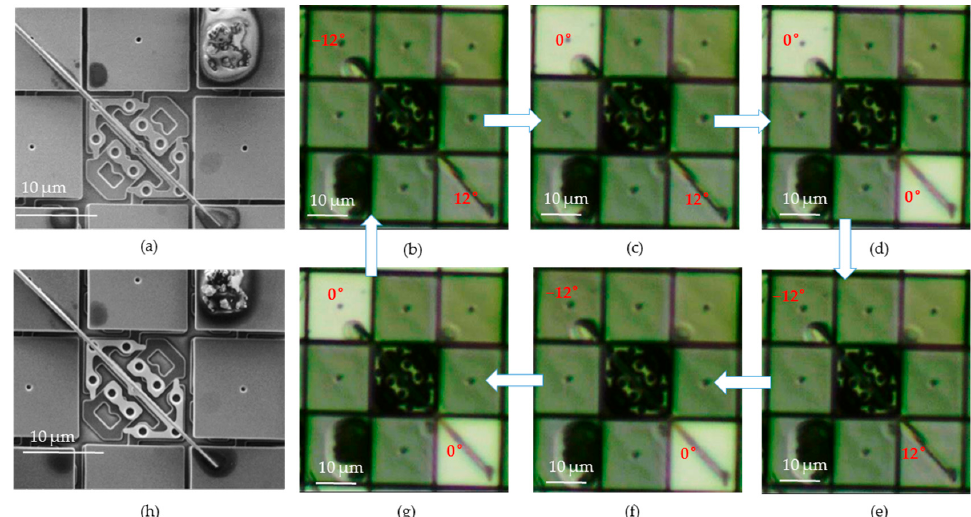
Figure 5. Cyclic torsional loading on a nanowire with maximum 24° twisting: From ( b ) to ( g ), the rotation angle changes as the picture shows. The maximum total torsion angle is 24° in this case (12° + 12°), with two diagonal mirrors titled in opposite directions. ( a ) shows the original nanowire with diameter ~500 nm before the test. ( h ) shows the same nanowire after the test.